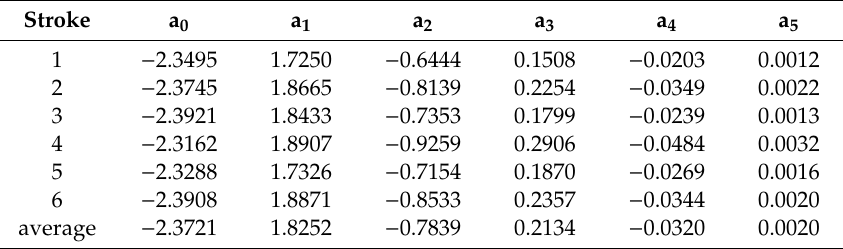
Figure 10. Repeated calibration curves at room temperature. Table 2. Repeated calibration fitting curve parameters. Table 3. Repeated calibration fitting curve